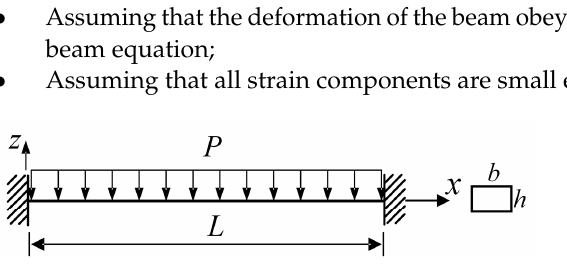
Figure 1. A clamped-clamped rectangular beam under pressure load.